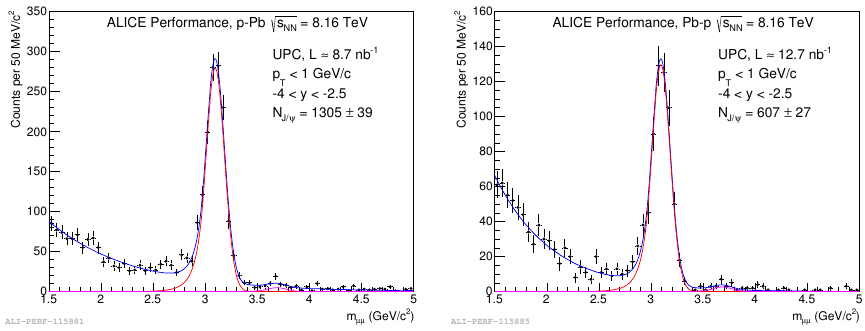
Figure 3. Invariant mass distributions for unlike-sign dimuons with pair p T < 1 GeV / c and rapidity − 4 < y < − 2 . 5 in ultra-peripheral p–Pb (left) and Pb-p (right) collisions at responding to γ p center-of-mass energy ranges 27 < W γ p < 57 GeV and 700 < W γ p < 1480 GeV respectively. J /ψ and ψ (2S) peaks are fitted with Crystal Ball functions on top of dimuon continuum fitted with an exponential